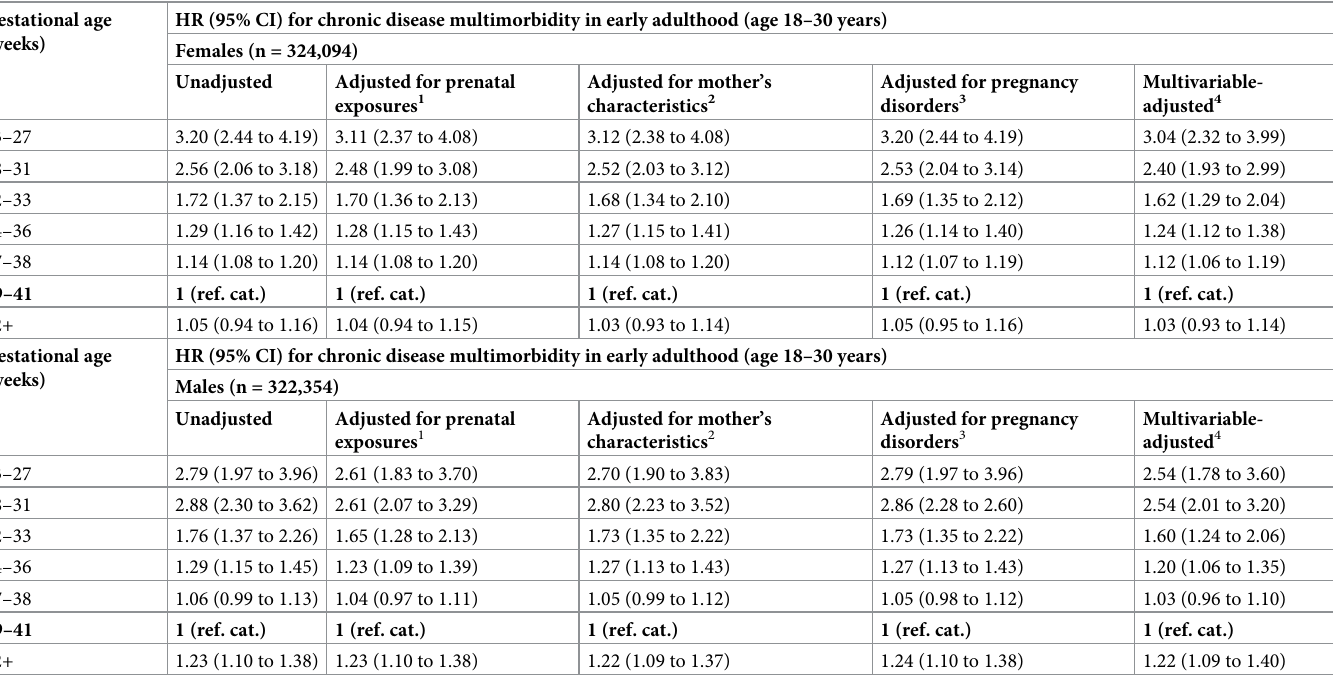
Table 3. Associations of gestational age with chronic disease multimorbidity in early adulthood (age 18–30 years) in females and males. Gestational age HR (95% CI) for chronic disease multimorbidity in early adulthood (age 18–30 years) (weeks)